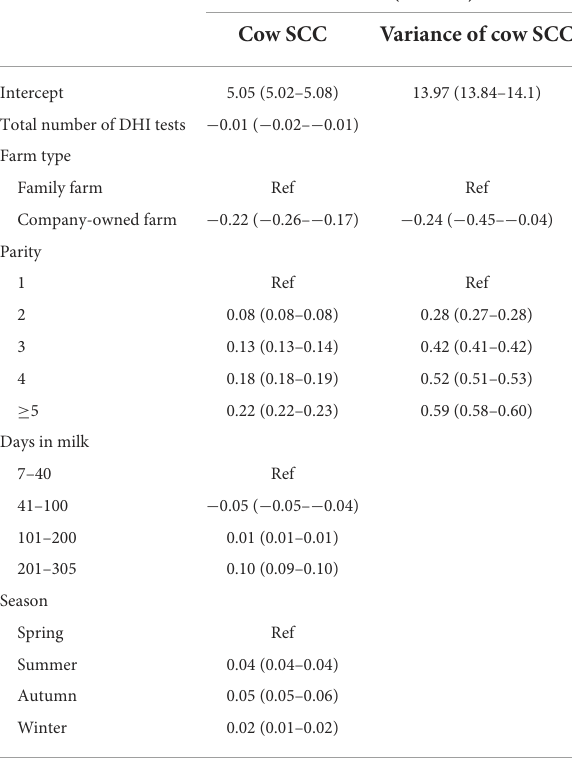
TABLE 3 Factors associated with cow-level high SCC among 131 herds in 11